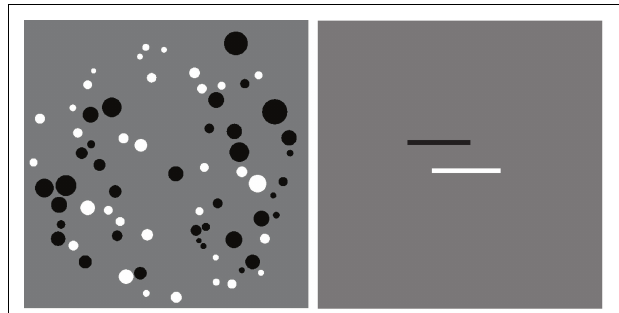
FIGURE 1 | Example stimuli from the numerical (left) and line length (right) tasks. The numerical stimulus has 33 white dots and 36 black dots and is an example of an 11:12 ratio.The black line in the line length stimulus is smaller than the white line by a factor of 11:12.